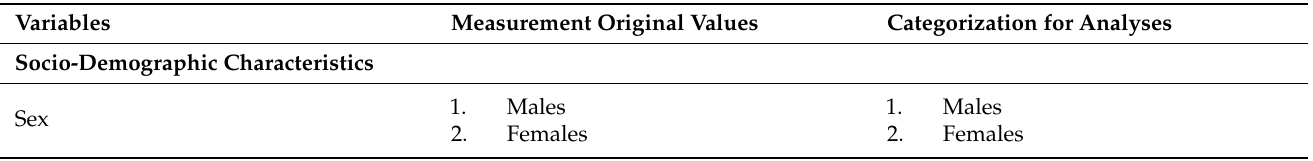
Table 1. Operationalization of study variables and their categorization for statistical analyses.